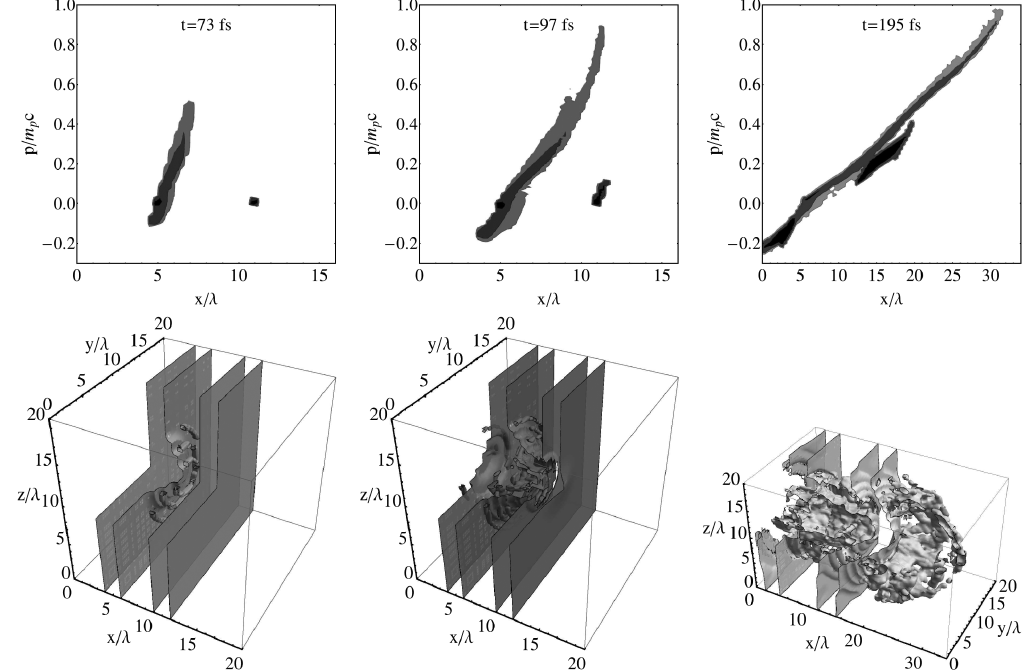
FIG. 4. Phase space (top) and density counter plot (bottom) of protons accelerated from contamination layers of low-density carbon target (case 1) at three instants: the film is situated between x ¼ 5 λ and x ¼ 11 λ .